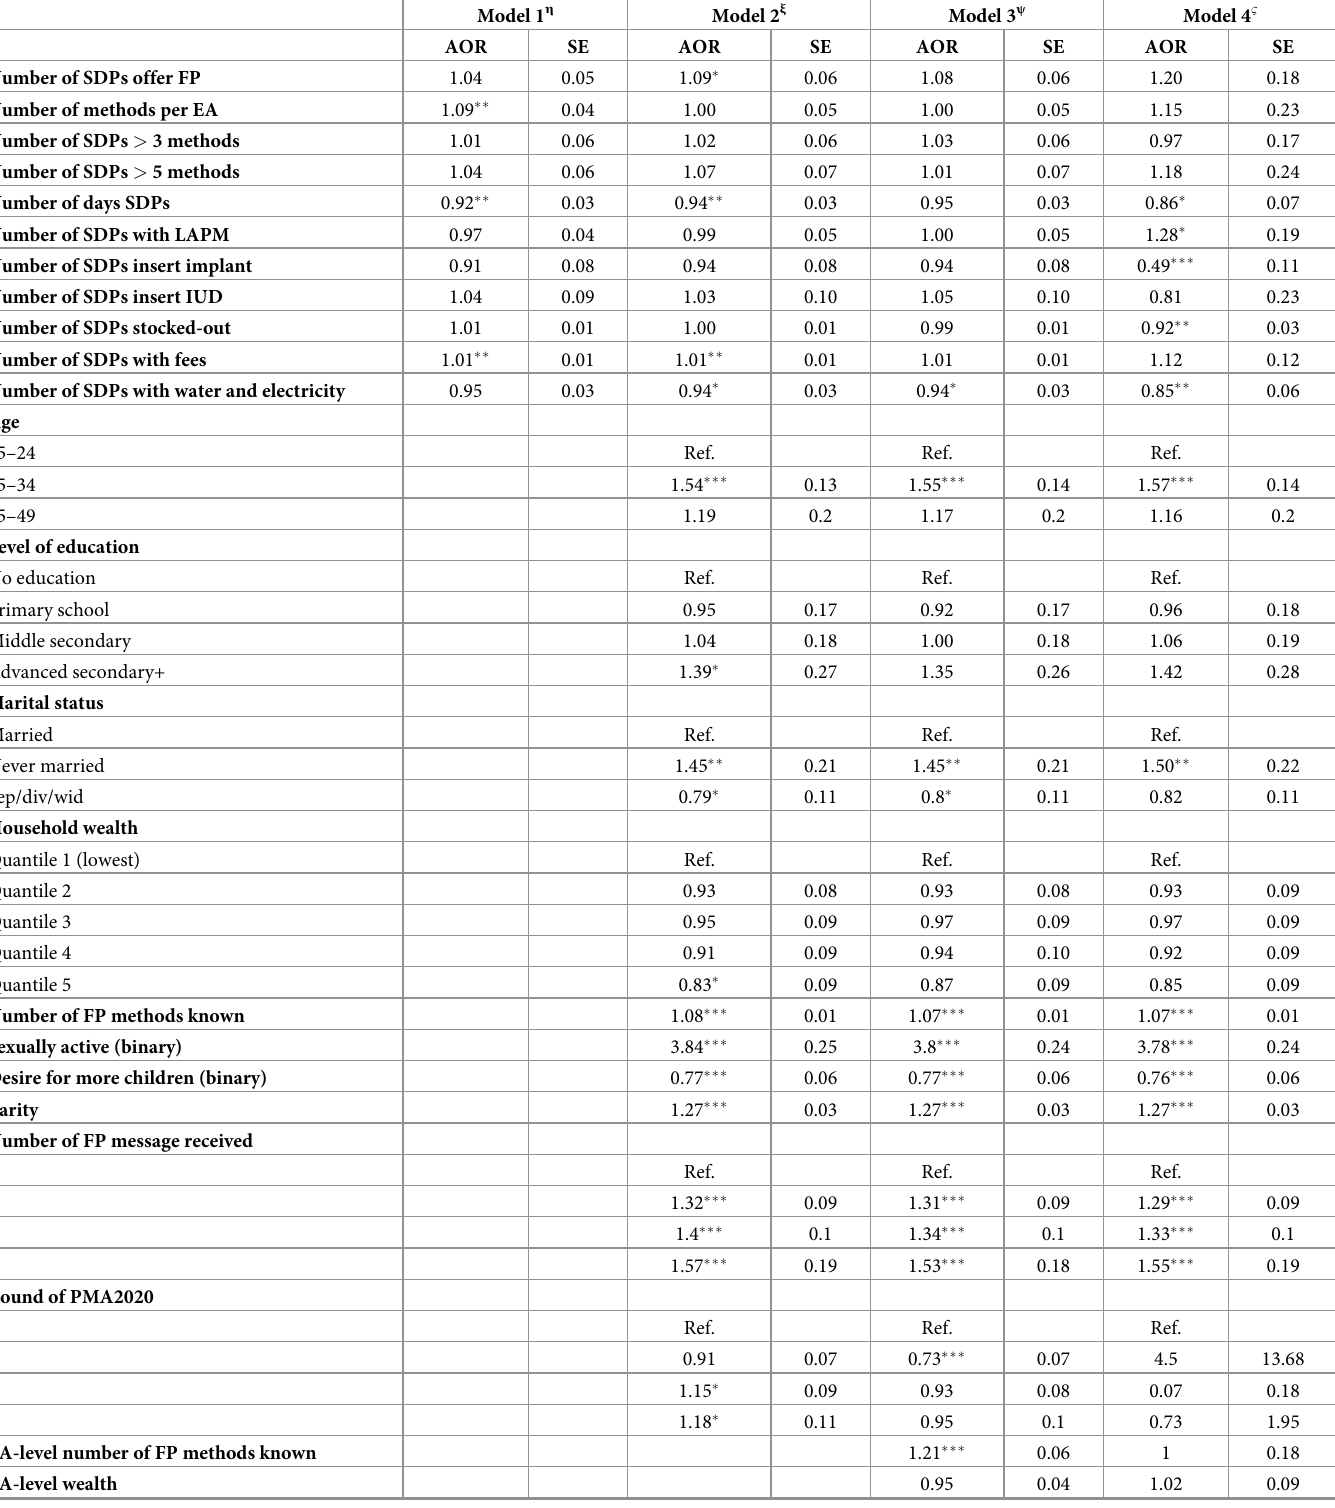
Table 5. Multivariate models for modern contraceptive use, PMA2020, Kinshasa,